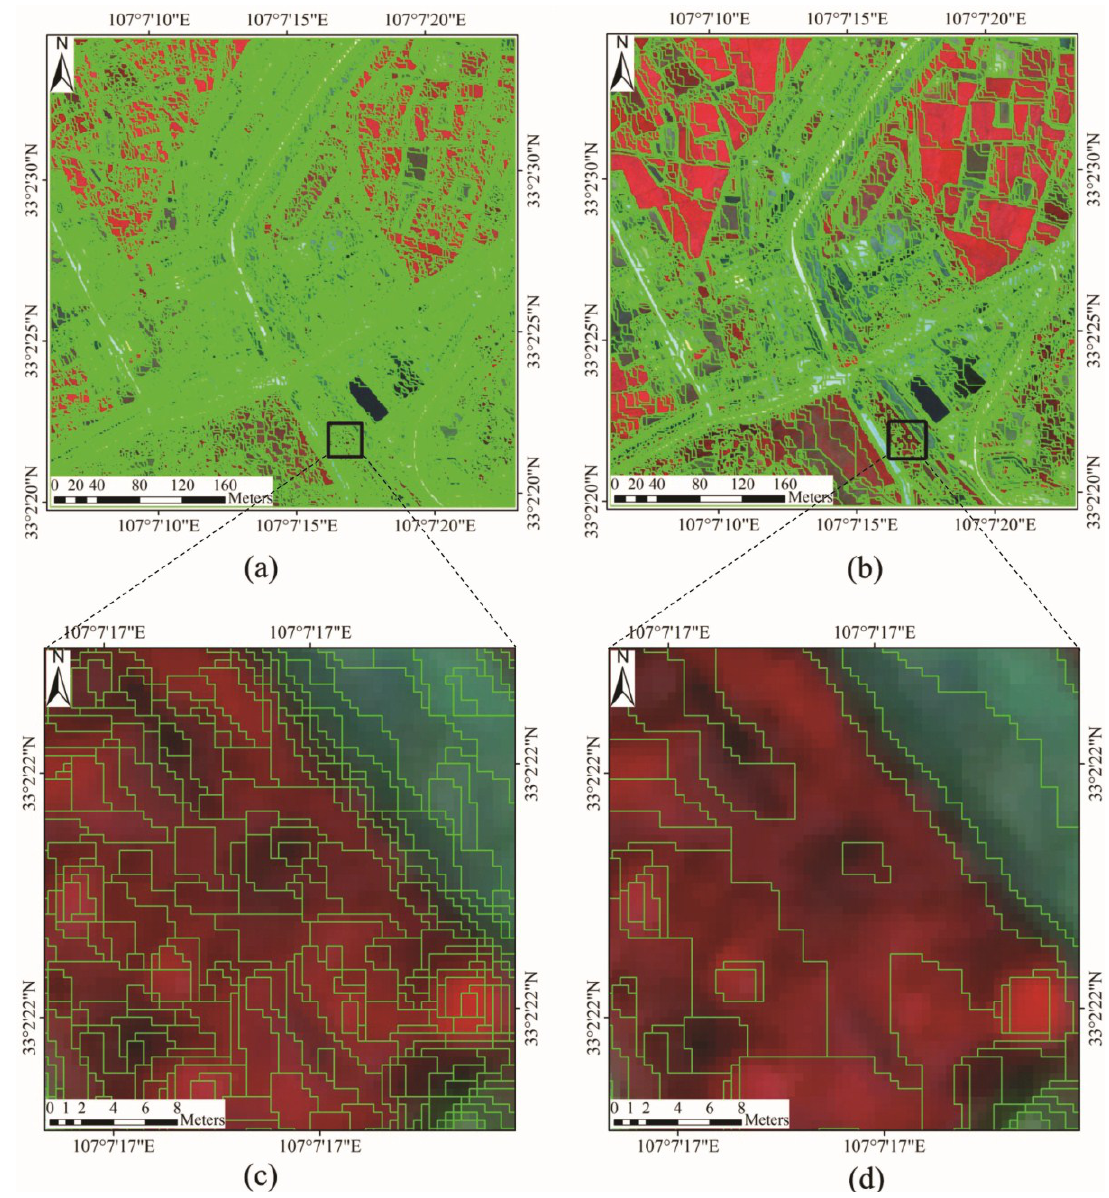
Figure 6. Initial segments of R1. ( a ) Threshold of 10 with 202,608 objects. ( b ) Threshold of 50 with 22,043 objects. Images ( c , d ) are zoomed-in area of ( a , b ),